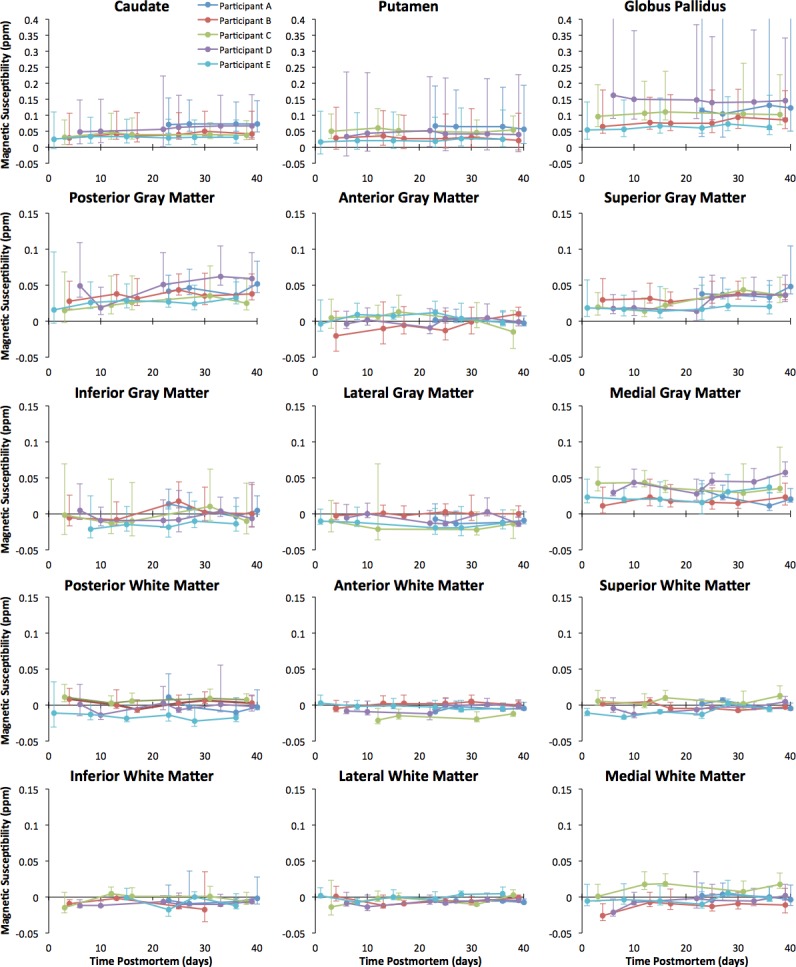
Magnetic susceptibility over time postmortem for gray and white matter regions.Plots of ex-vivo magnetic susceptibility in selected gray and white matter regions as a function of time postmortem, for all hemispheres of Dataset 1. Error bars around individual data points represent the 95% confidence interval of the susceptibility values within the region at that specific time point.